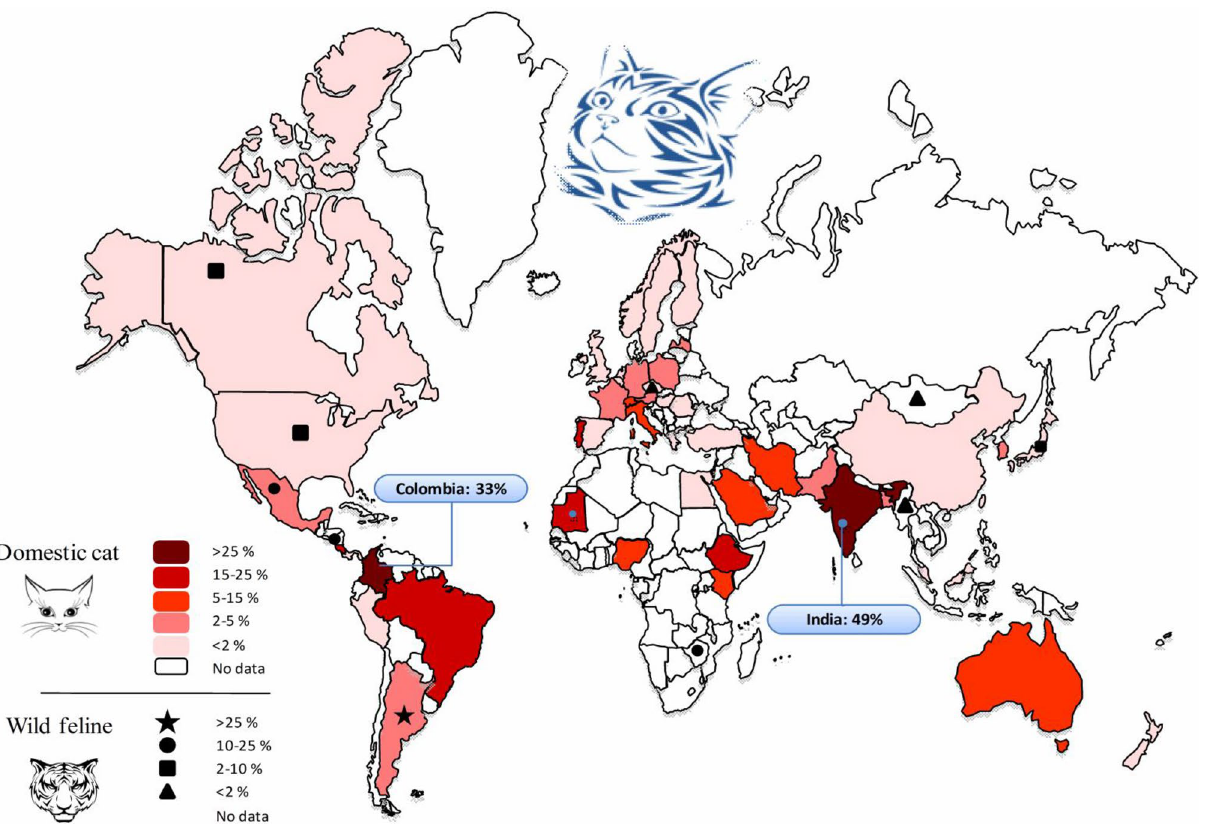
Figure 4. Pooled prevalence of Toxoplasma -like oocysts detected in domestic and wild feline stool samples in different countries (Map created by PowerPoint Microsoft office, source of image: https:// commo ns. wikim edia. org/ wiki/ File: Blank Map- World.